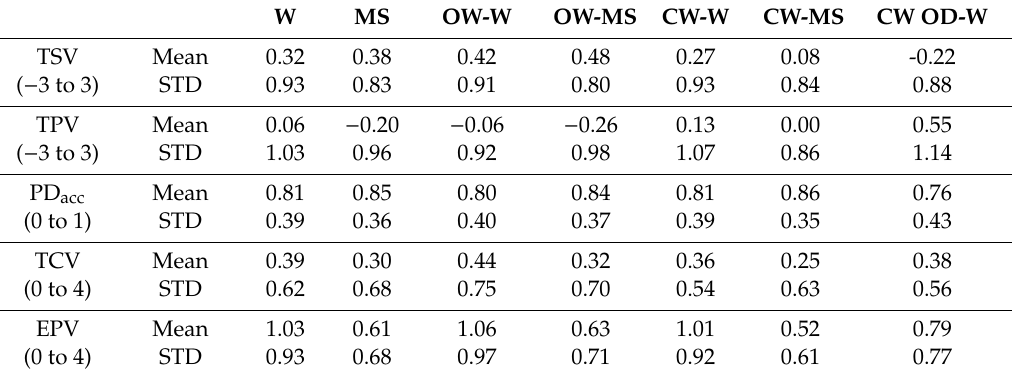
Table 6. Mean values of occupants’ votes obtained during the field measurements related to seasons and windows’ and doors’ operation.